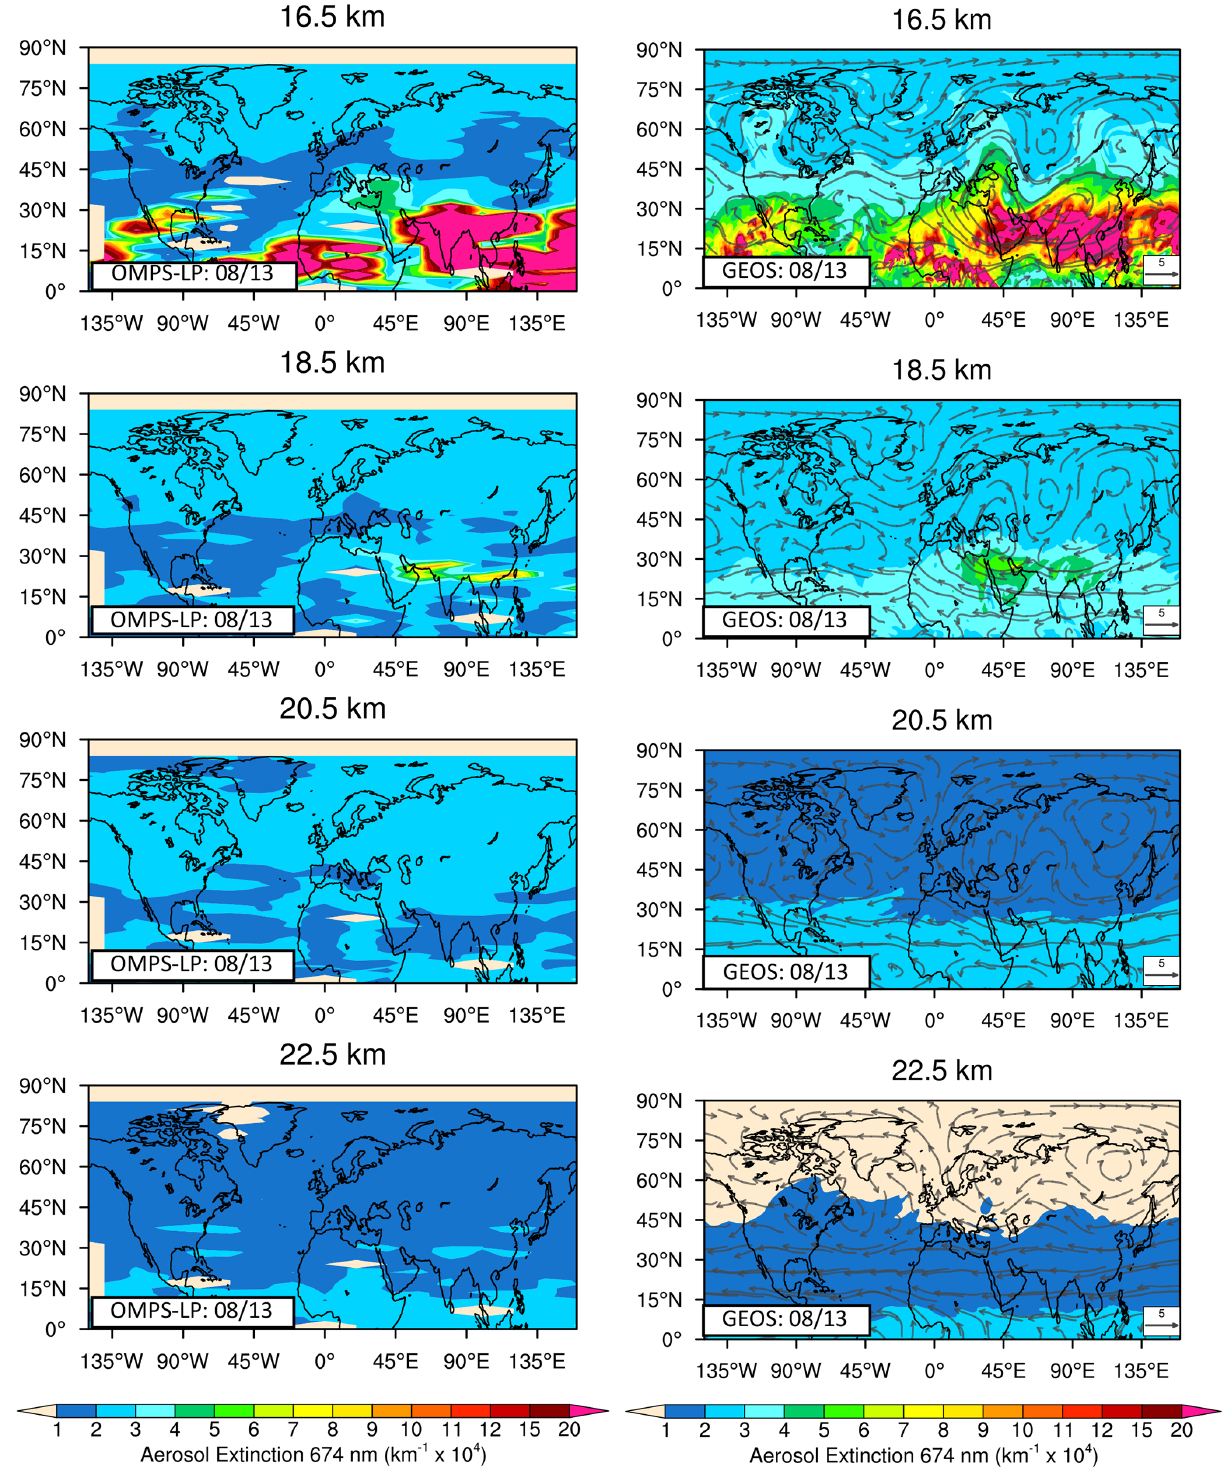
Figure 6. Background state on injection day. OMPS-LP-retrieved (left column) and GEOS-simulated (right column) total aerosol extinctions (km − 1 × 10 4 ) at 674nm at altitudes from 16 to 22km (top to bottom) on the injection day of 13 August 2017. The simulated wind vectors are overlaid on the model contour plots to depict the trajectory of transport at different altitudes and identification of the anticyclonic flow of the Asian summer